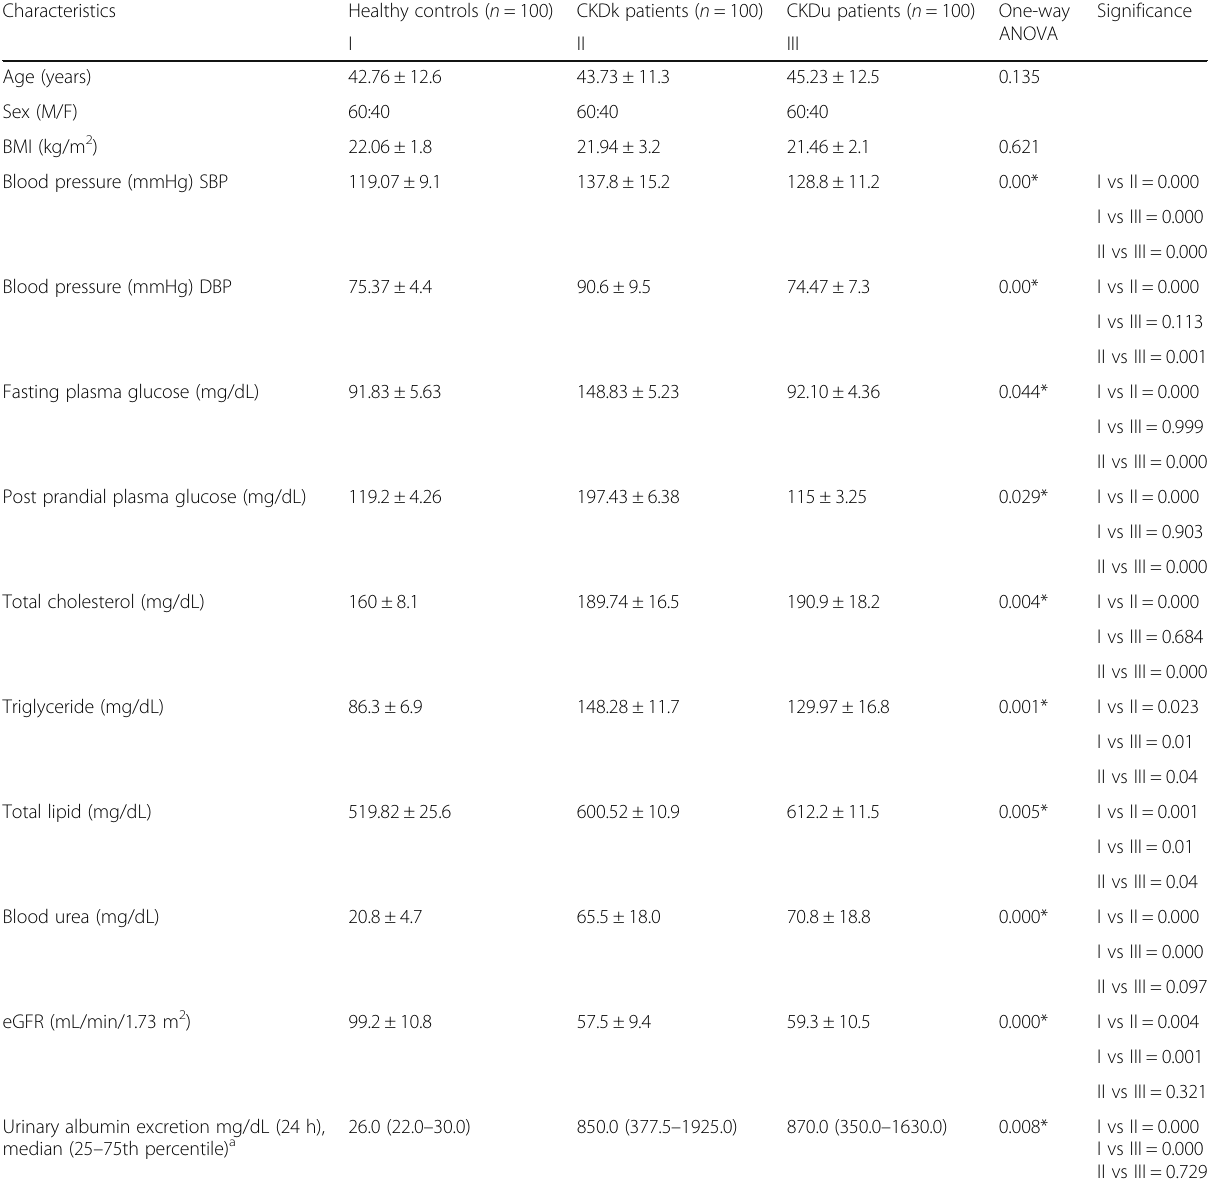
Table 1 Demographic features and biochemical parameters of the study subjects